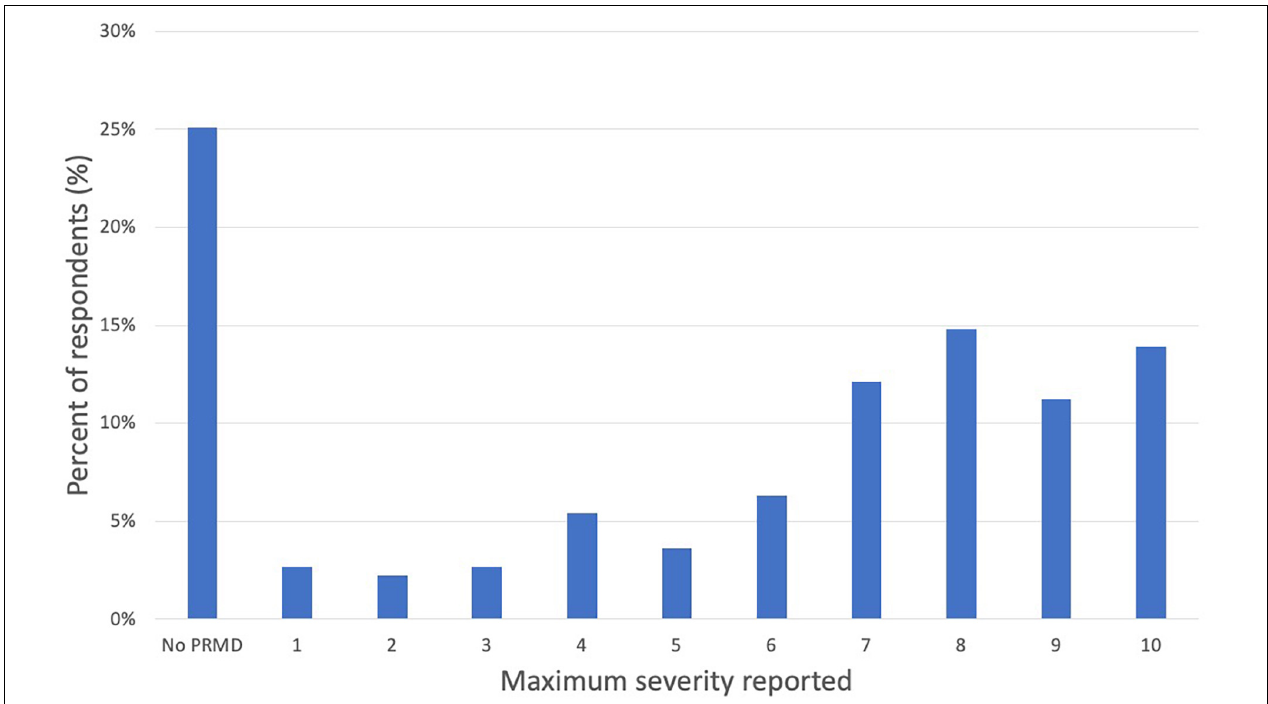
FIGURE 3 | Distribution of maximum severity reported (scale of 1 to